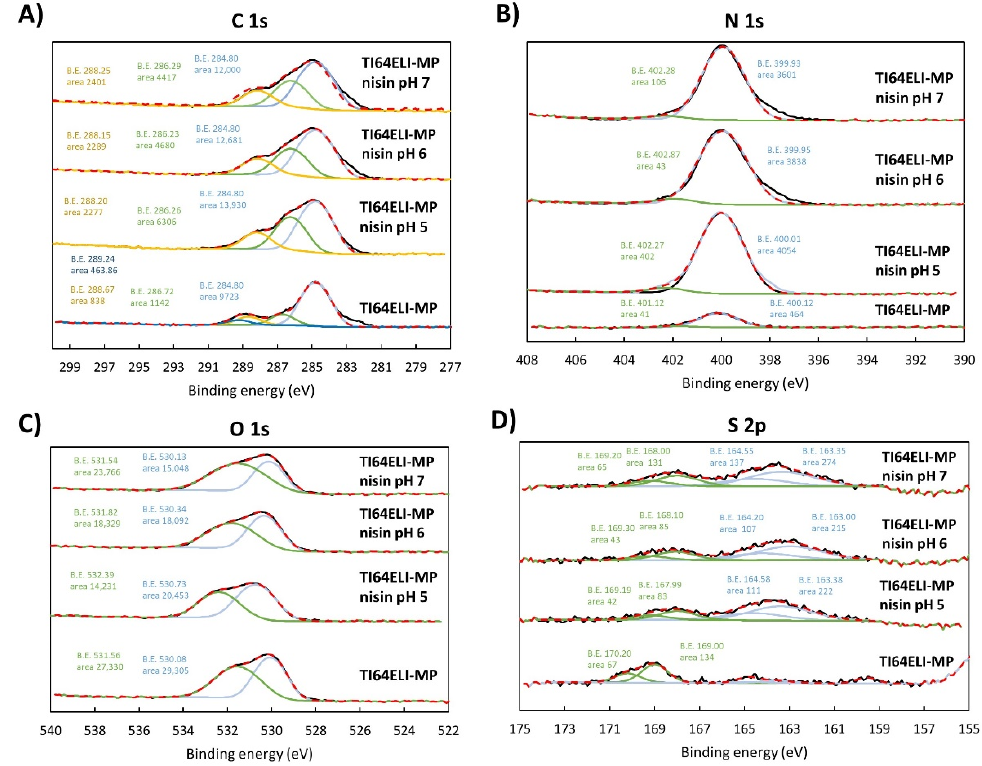
Figure 8. High-resolution spectra of ( A ) C 1s, ( B ) N 1s, ( C ) O 1s, and ( D ) S 2p regions of the bare MP sample and surfaces functionalized with processes at different pH values. Black line (-): spectrum line, red dashed line (- - -): composite line.